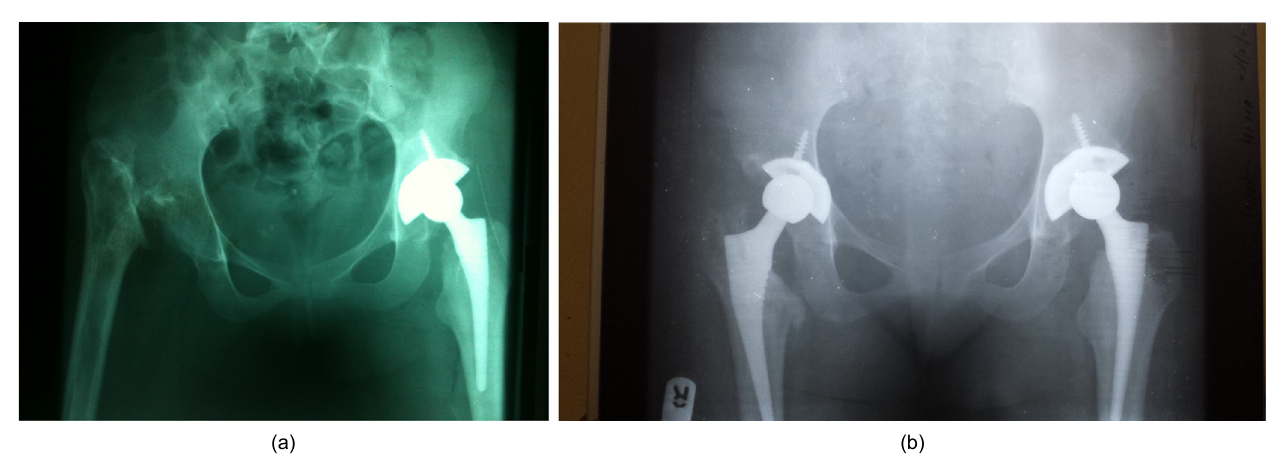
Figure 1. (a) Preoperative X-ray with resection arthroplasty of the right hip and THR prosthesis insitu left hip. (b) Post operative X-ray after THR of the right